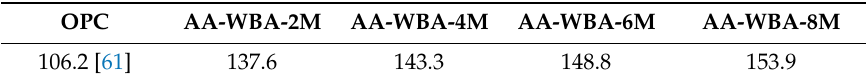
Table 6. Cost ( € · t − 1 binder) of AA-WBA